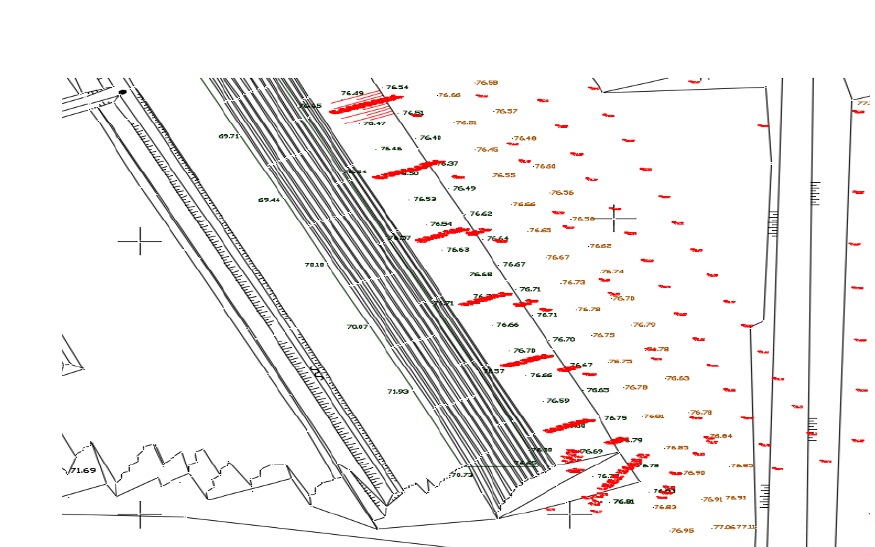
Figure 7 – Downloading the recording data onto the existing map Рис . 7 – Загрузка замеренных данных на существующую карту Слика 7 – Учитавање података снимања на постојећу